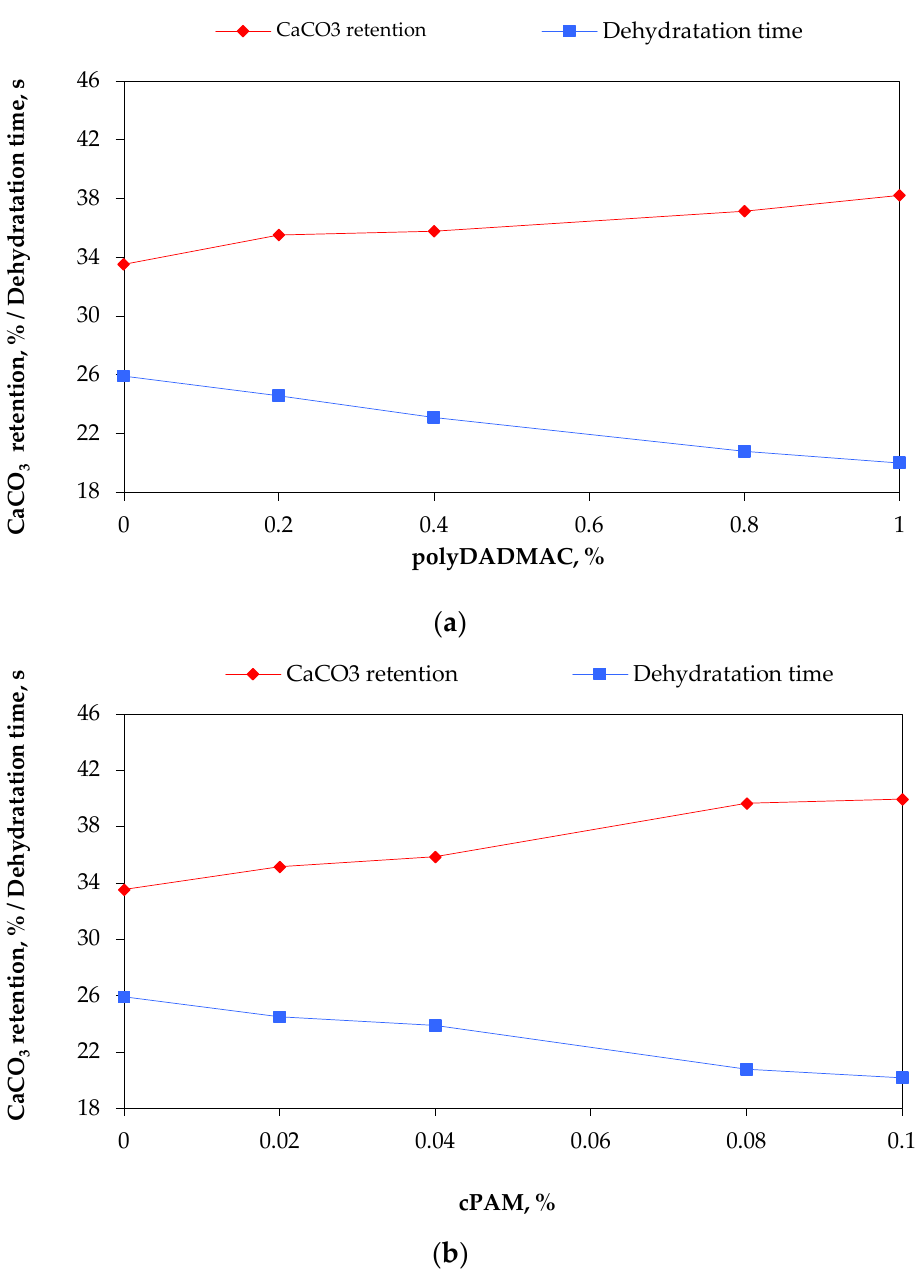
Figure 1. Influence of pDADMAC ( a ) and cPAM ( b ) polymers on PCC retention and dehydration time of PCC filled fibers.